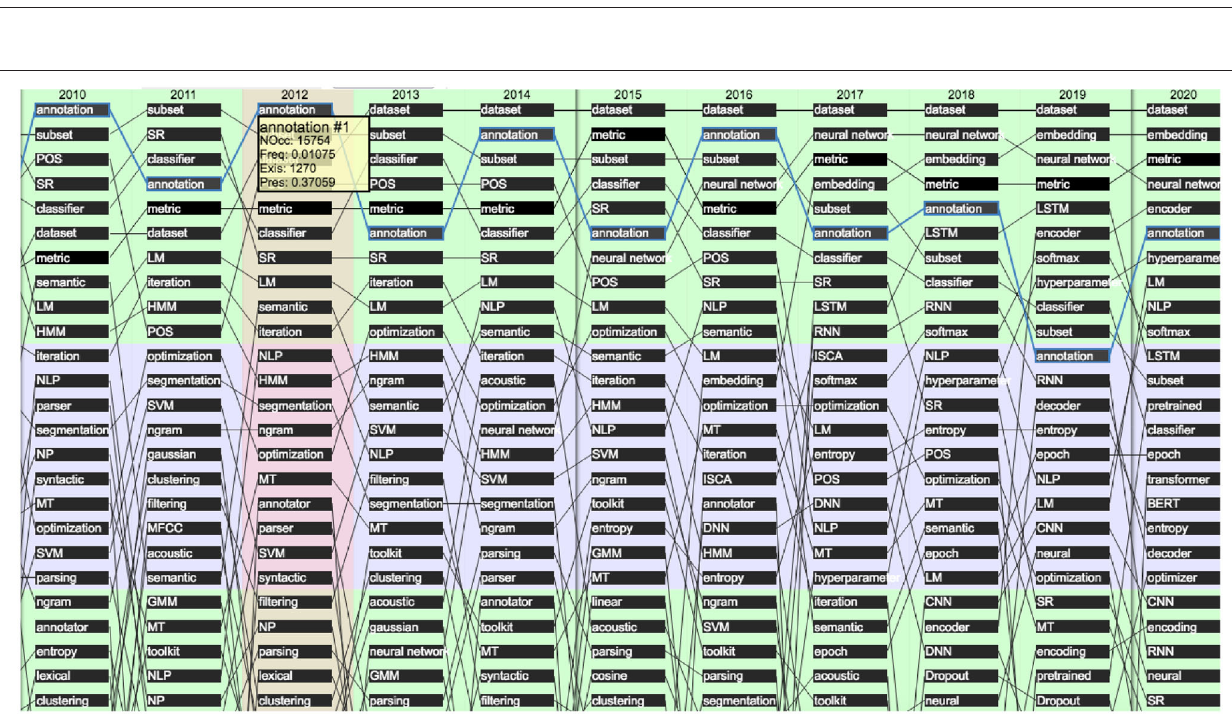
FIGURE 32 | Evolution of the top 25 terms over the past 10 years (2010 to 2020) according to their presence (raw ranking without